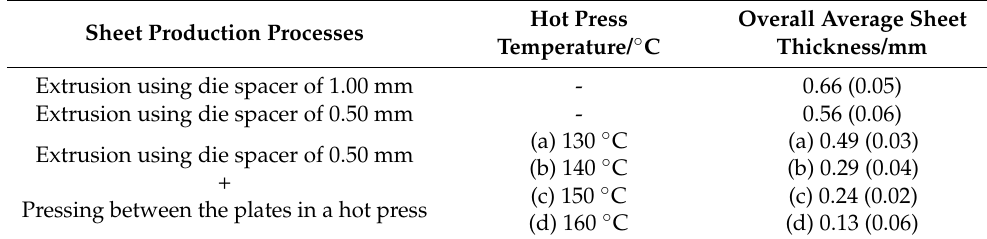
Table 2. The polymer sheet production processes and the overall average thickness of the polymer sheets. Standard deviations are shown in parentheses.